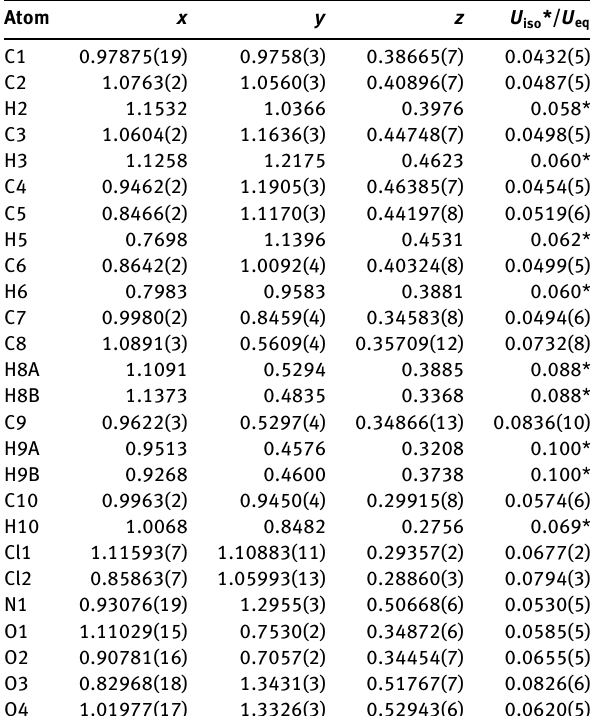
Table 2: Fractional atomic coordinates and isotropic or equivalent isotropic displacement parameters (Å 2